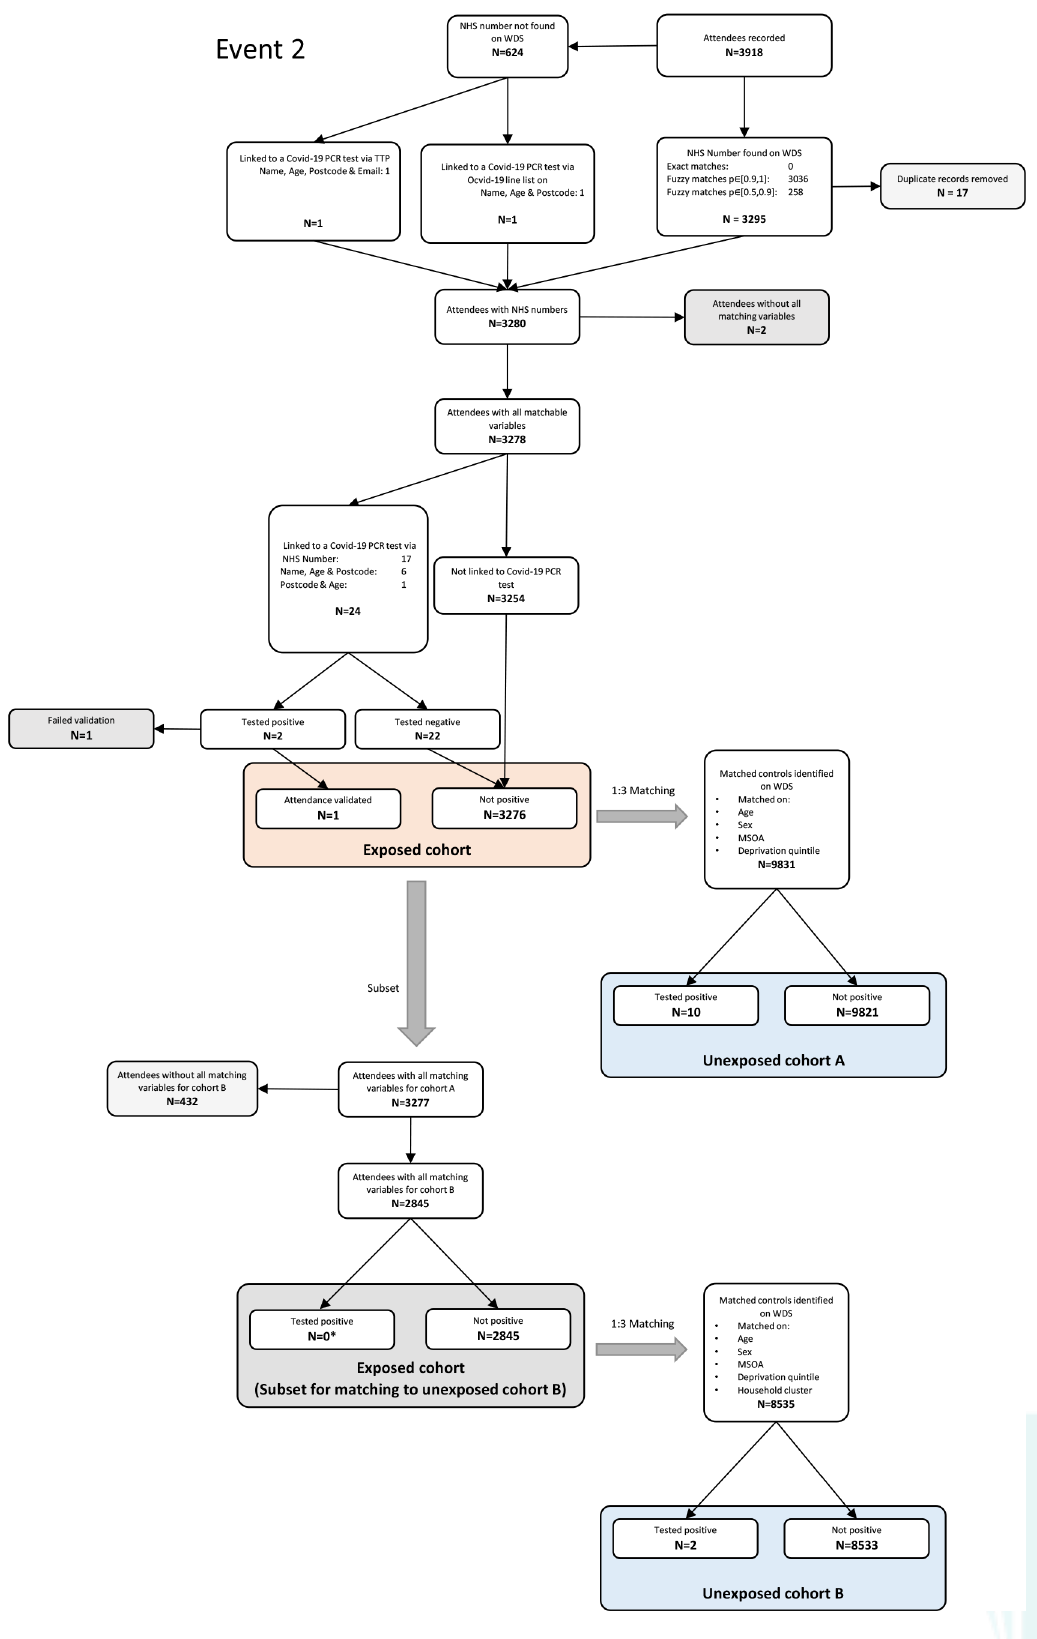
Figure S2: Flow chart of cohort selection for event